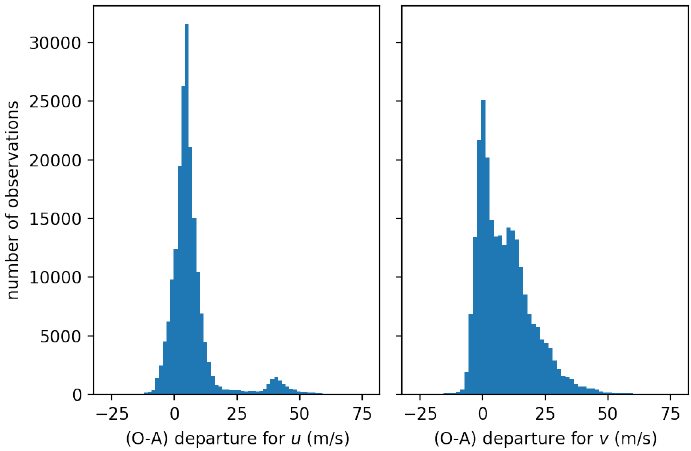
Figure 3. Distribution of (O-A) for zonal ( u , left ) and meridian ( v , right ) components of wind speed. Only values for u and v above 15 m · s − 1 are selected. Data are distributed in 60